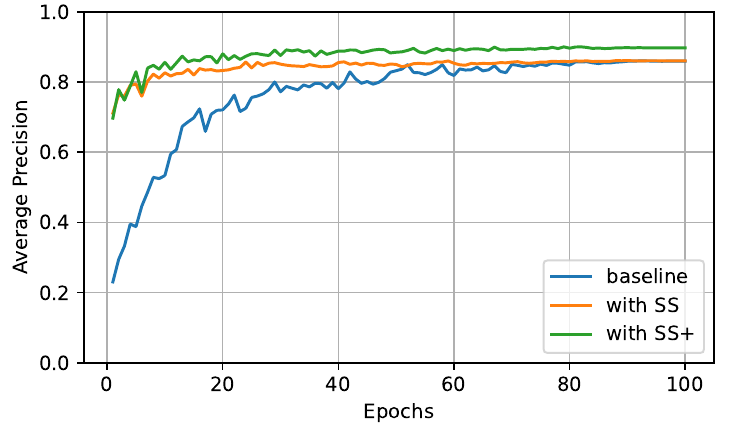
Figure 5. Improvements in self-supervised pretraining. Compared to the baseline approach, the contrastive subclips method (SS+) makes the training process faster to converge and increases the final